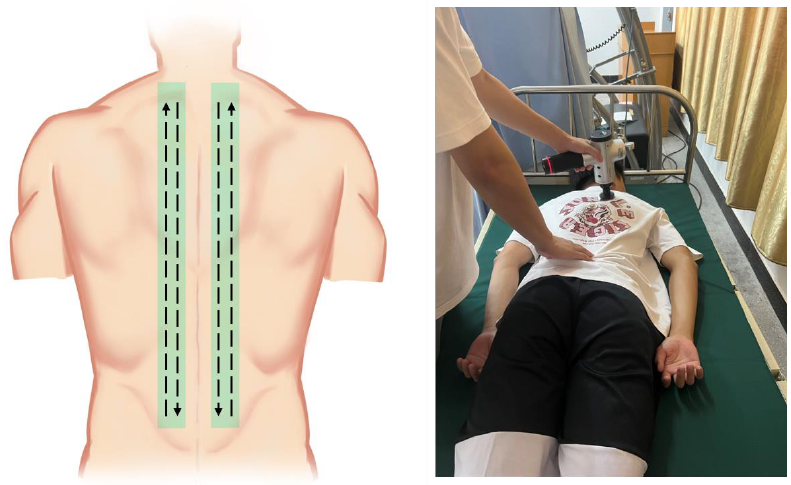
Figure 1. Percussive massage therapy diagram.